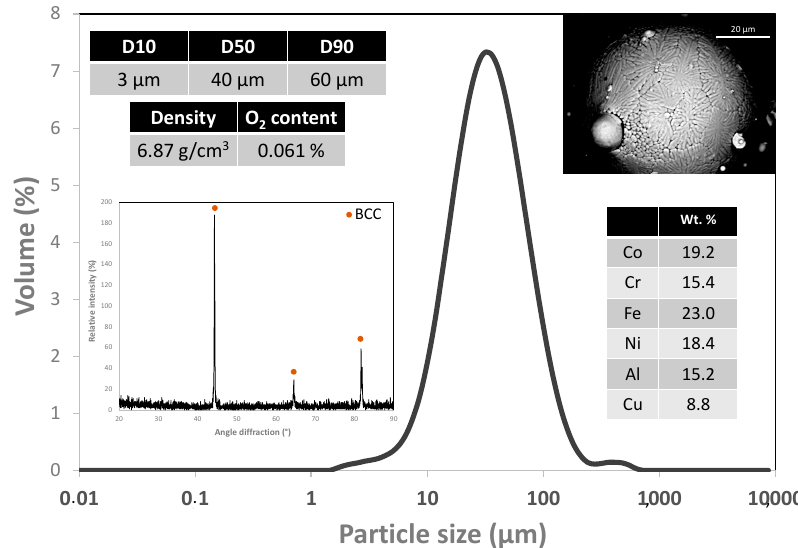
Figure 2. Basic characteristics of the FeCrCoNiAl 1.8 Cu 0.5 atomised powder.